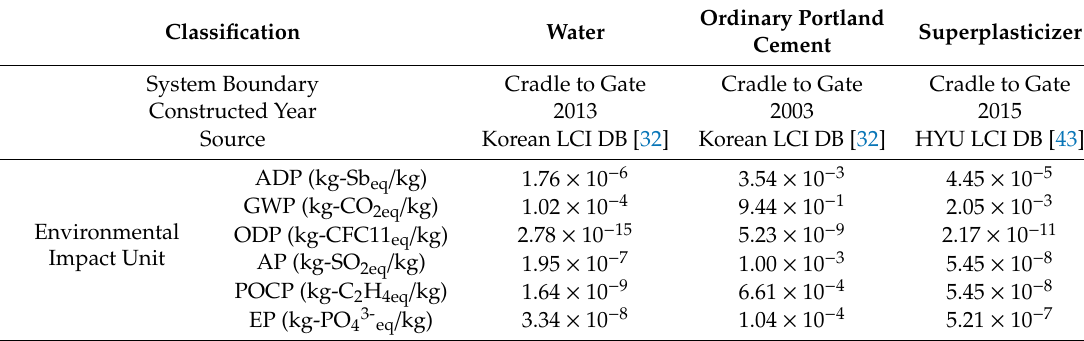
Table 4. LCI DB Information for Water, Ordinary Portland Cement, and